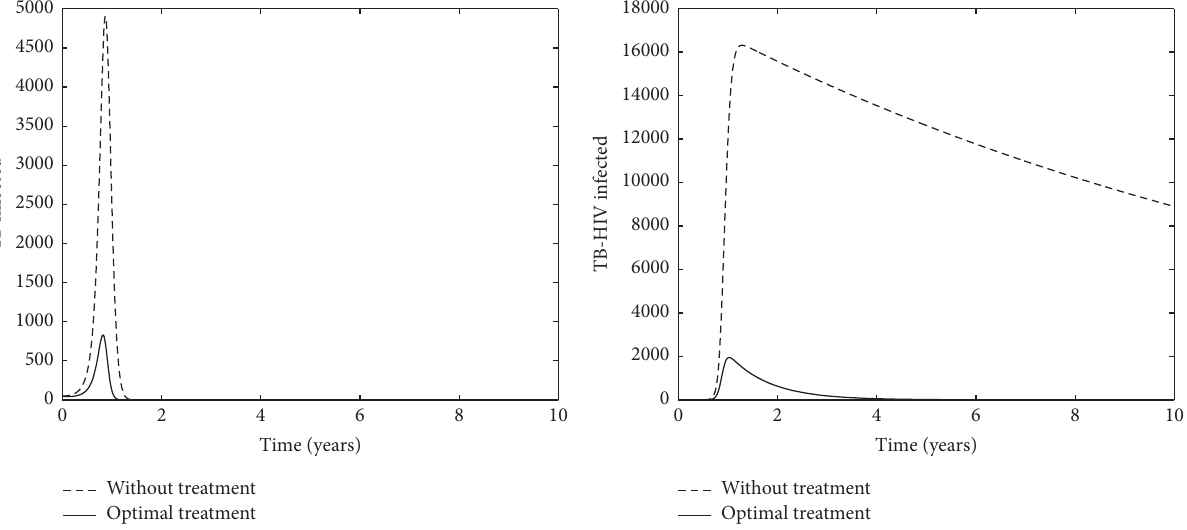
Figure 13: The dynamics of 𝐼 𝑡 and 𝐼 ℎ𝑡 using controls 𝑢 ∗ 1 and 𝑢 ∗ 2 .